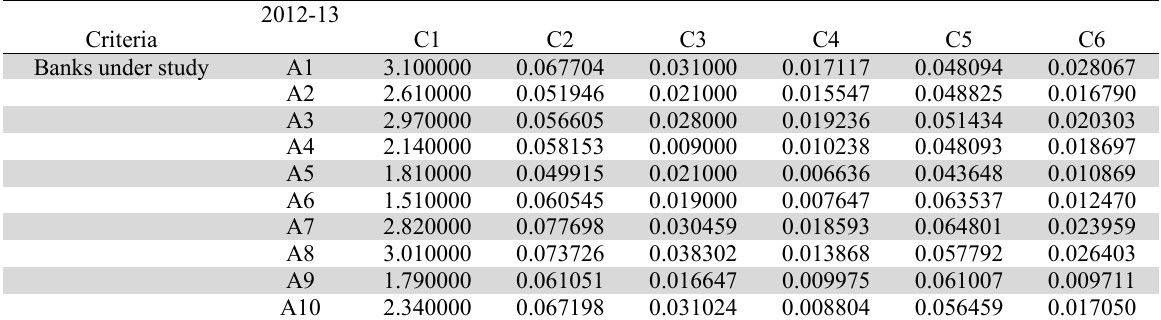
Descriptive Statistics (Fy